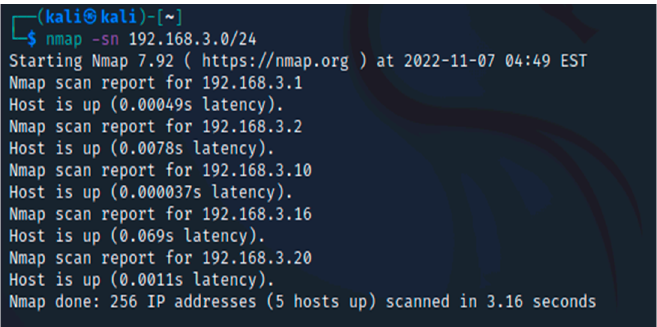
Figure 15. Nmap scan with -sn option after solving the issues.